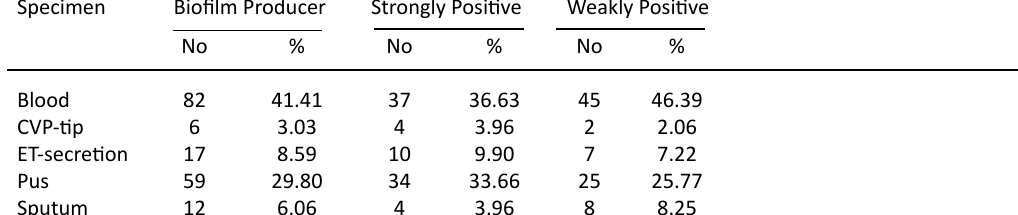
Table 3. Distribution of Biofilm Producers According to Clinical Samples Specimen